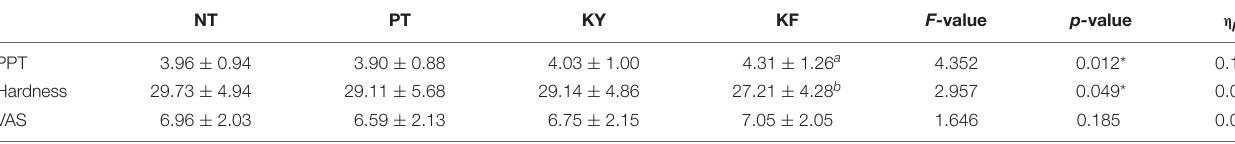
TABLE 3 | Comparison of the different taping methods in terms of PPT (kg/cm2), Hardness (N), and VAS scores ( ¯ x ± s ). NT